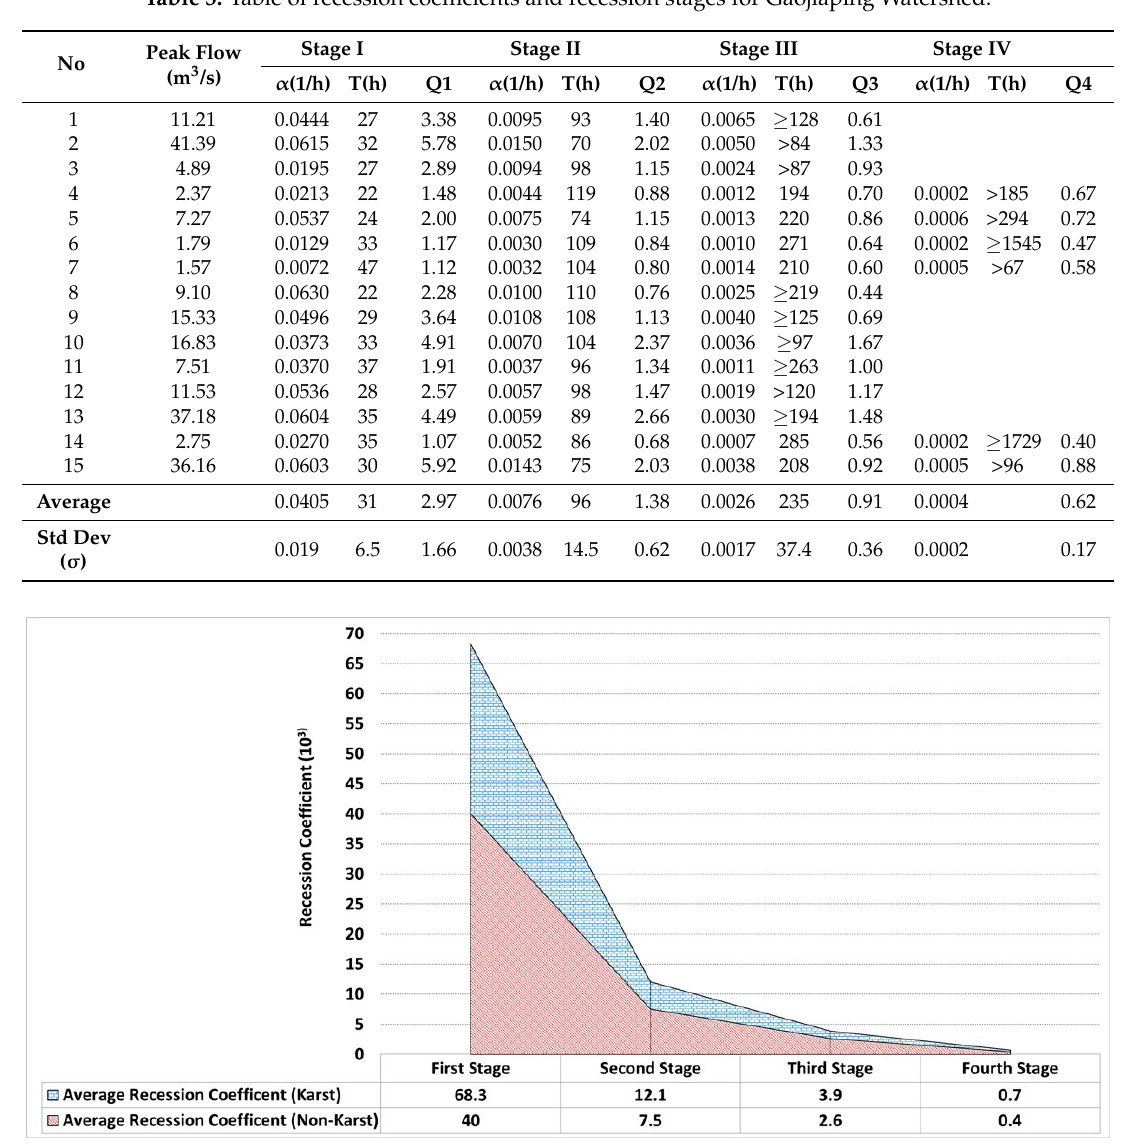
Figure 9. Average recession coefficients of the four stages of the recession curves.